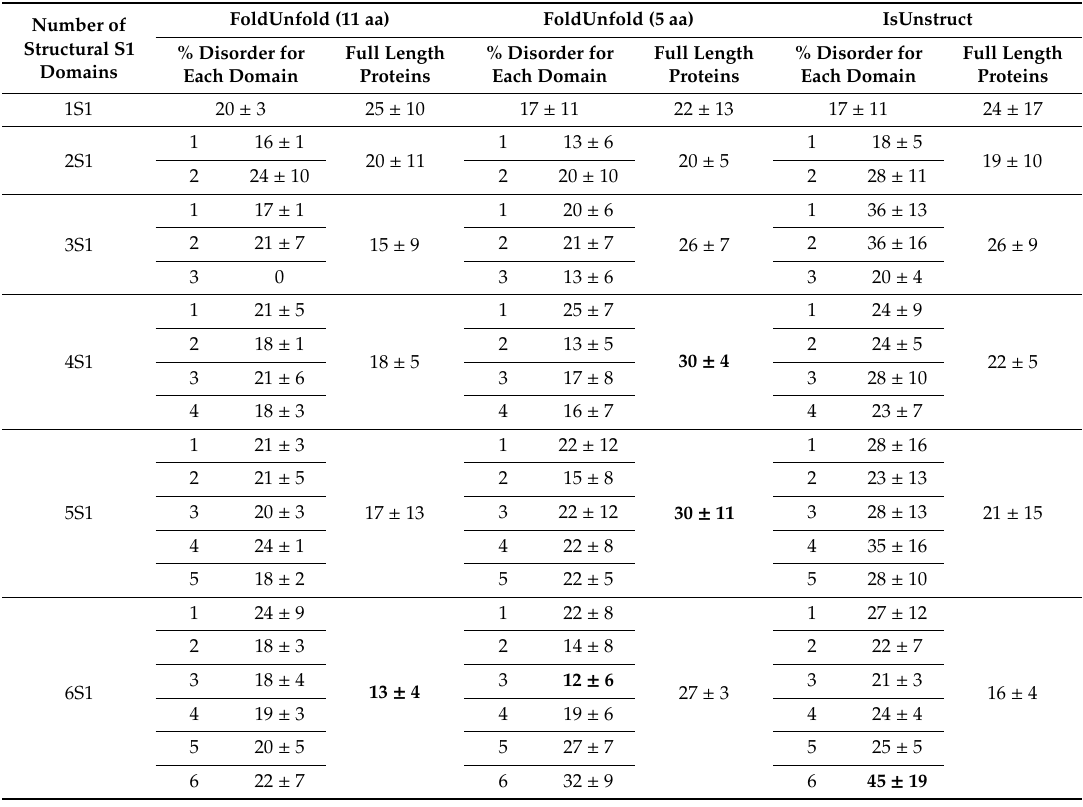
Table 1. Intrinsic flexibility and disorder of S1 protein family and its structural domains. The largest and smallest values are highlighted in